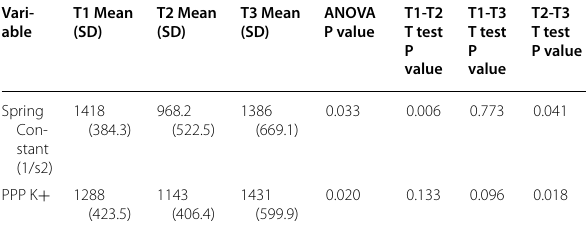
Table 1. Spring Constant and Pressure Phase Plane (PPP) K K values at admission (T1), after commencement of vasopressor − (T2), and at discharge from ICU